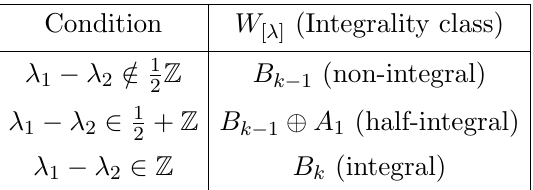
(cid:6) e for 1 (cid:20) i < j (cid:20) k for which h (cid:21); (cid:11) _ i = (cid:21) i j ; : : : ; (cid:21) ) 2 Z k (cid:0) 1 [ ( Z + 1 2 k for 2 (cid:20) i (cid:20) k satisfy h (cid:21); (cid:11) _ i 2 Z . We have to examine i